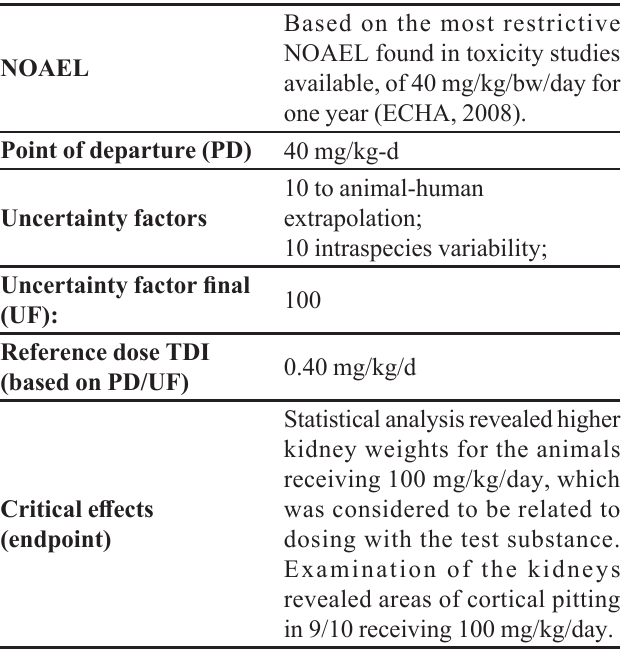
TABLE V - Determination of the Reference Dose of ketoprofen (base value for not carcinogenic substances) Determination of the reference dose of ketoprofen